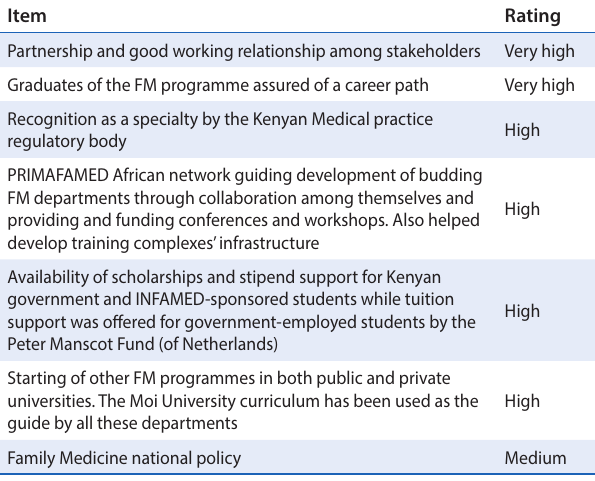
Table 2: Enabling factors in the development of FM in Kenya Item Rating